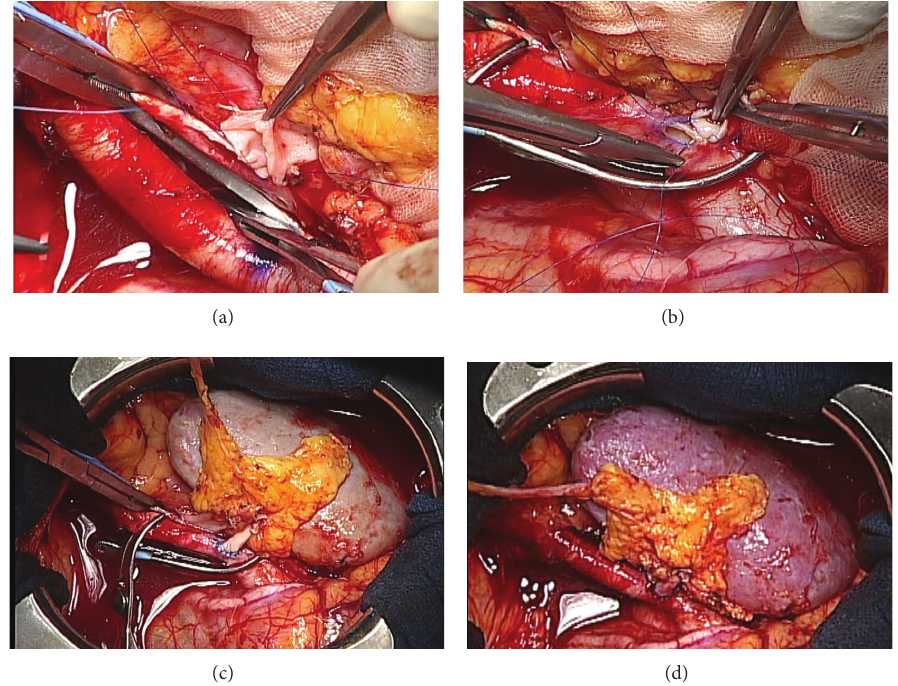
Figure 2: (a) The left renal vein of donor kidney anastomosed to the right external iliac artery end-to-side with a continuous suture. (b) The renal artery anastomosed to the right iliac artery by end-to-side, continuous and interrupted sutures. (c) All anastomoses completed right before the declamping of vessels. (d) There was no bleeding at the anastomoses, and blood flow to the renal artery was